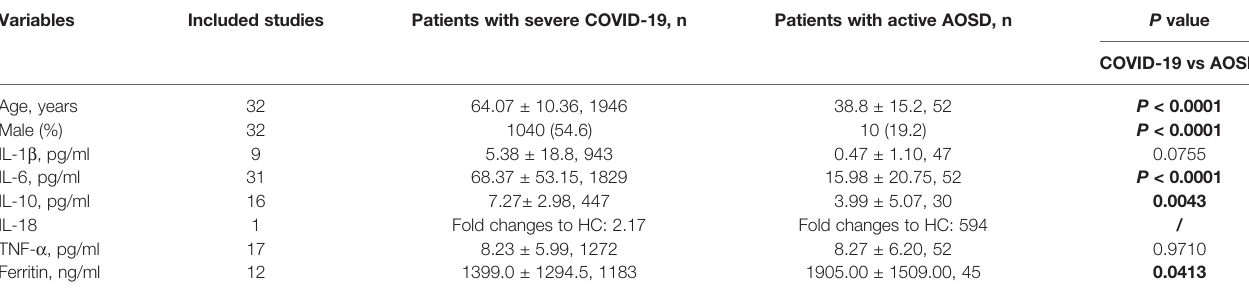
TABLE 3 | Comparative results of cytokine and ferritin level between severe COVID-19 and active AOSD using meta-analysis. Variables